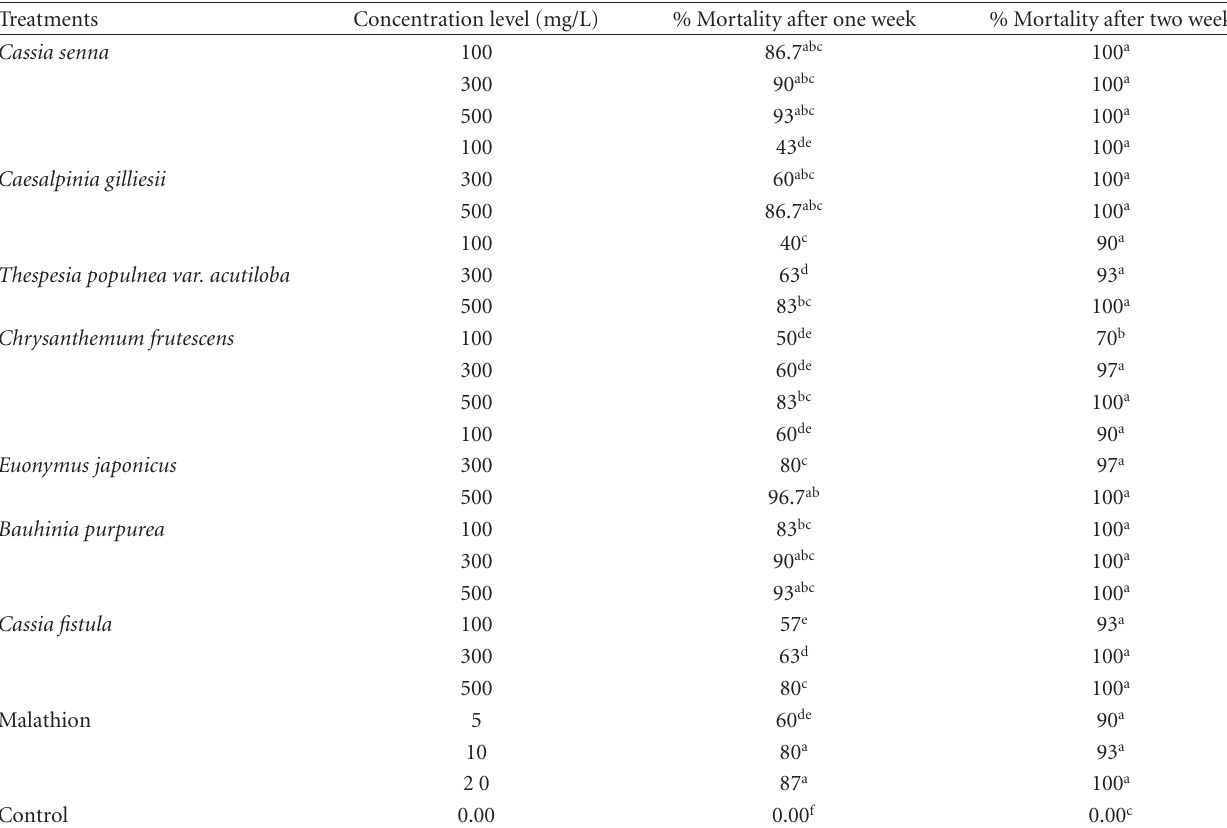
Table 2: E ff ect of the tested plant extracts and malathion on adult’s mortality of T. granarium .